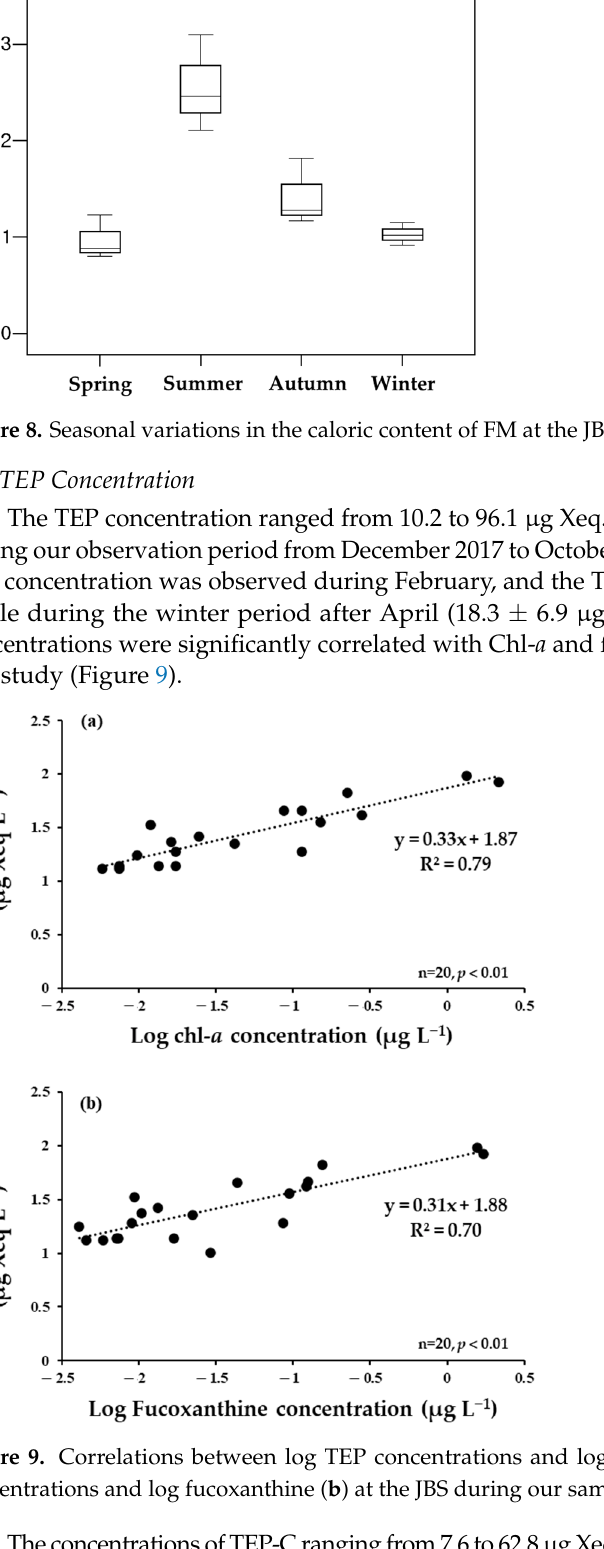
Figure 7. Variations in concentrations ( a ) and relative contributions ( b ) of carbohydrate (CHO), pro-